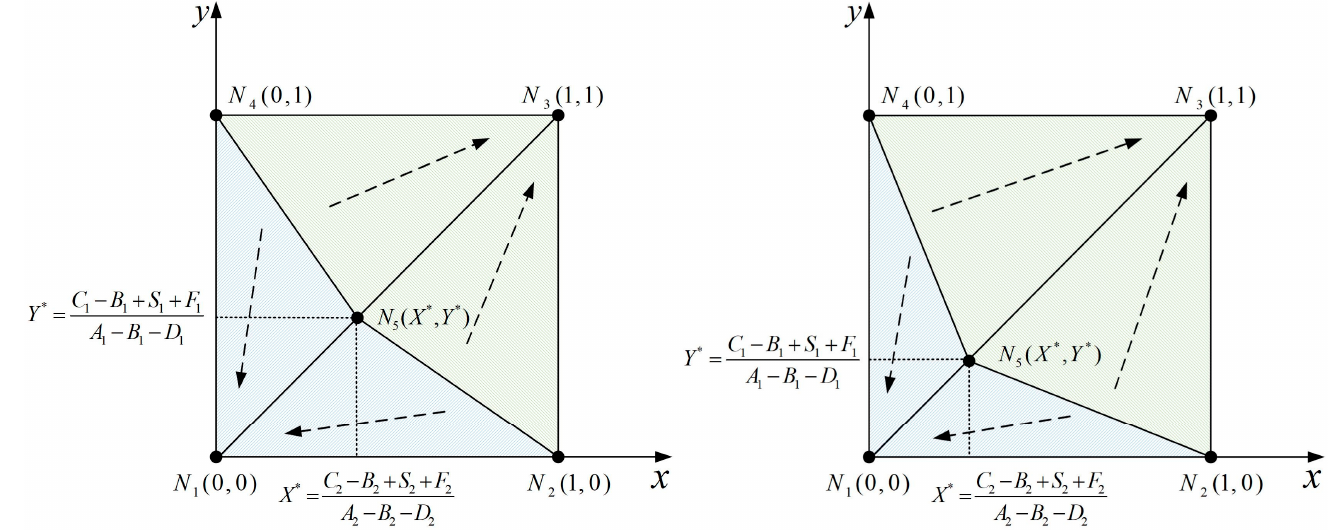
Figure 6. Phase diagram of the evolution of upstream and downstream governments’ decision-making behavior (with the supervision of the central government).